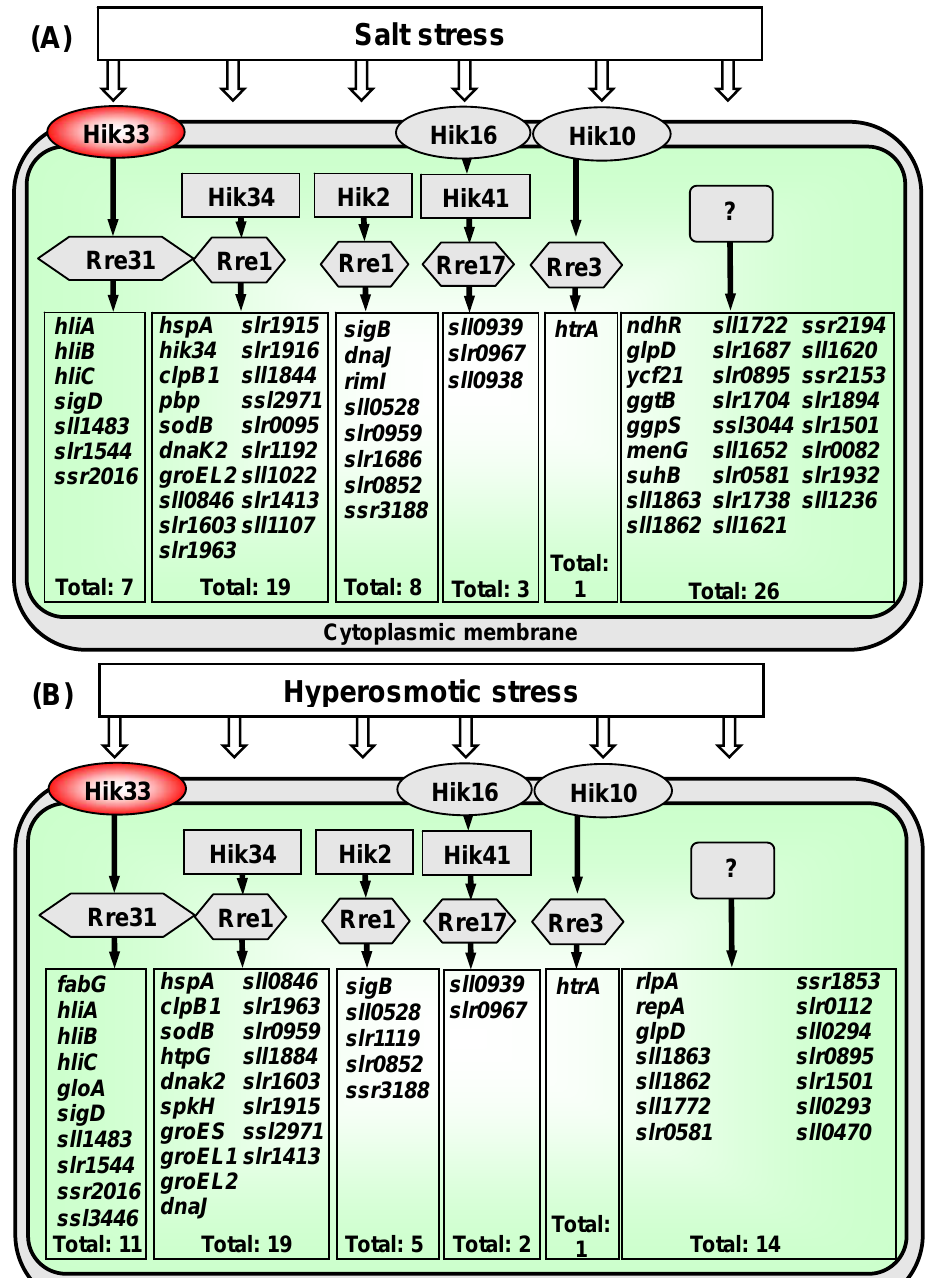
Figure 5. Hypothetical schemes of two-component systems that are involved in the transduction of salt stress (A) and hyperosmotic stress (B), as well as the genes that are under the control of the individual two-component systems. Primary signals are represented by open arrows. Hiks that posess transmembrane domains are indicated as ellipses (Hik33, Hik16, Hik10); Hik33 is in a red ellipse; soluble Hiks are shown as horizontal boxes (Hik34, Hik2, Hik41); Rres are indicated as hexagons, and selectively regulated genes are shown in vertical boxes. Uncharacterized mechanisms are represented by question marks. Genes with induction factors higher than 4.0 are included in these schemes. Adopted from [28]. Published with permission of Horizon Scientific Press / Caister Academic